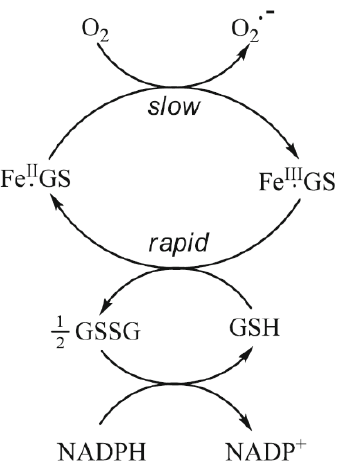
Figure 2. Speciation plot of iron(II) in the presence of cytosolic levels of glutathione and citrate.